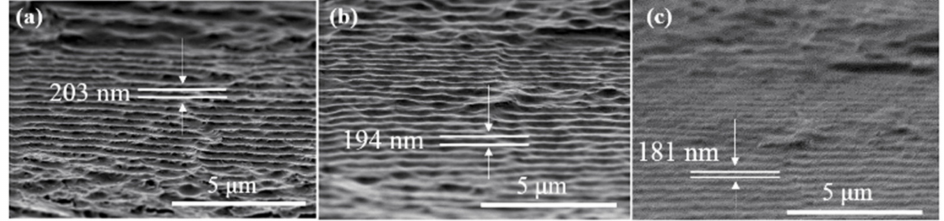
Figure 7. SEM images of the cross-section of the ( a ) pure CNC film, ( b ) CNC/DS4 film, ( c ) CNC/DS6